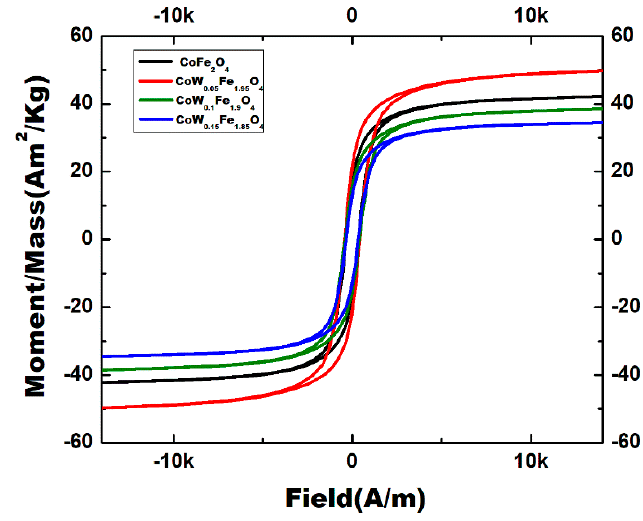
Figure 10. H-M hysteresis loops of CoW x Fe 2 − 2x O 4 samples. Table 4. The magnetic properties of the CoW x Fe 2 − 2x O 4 samples.